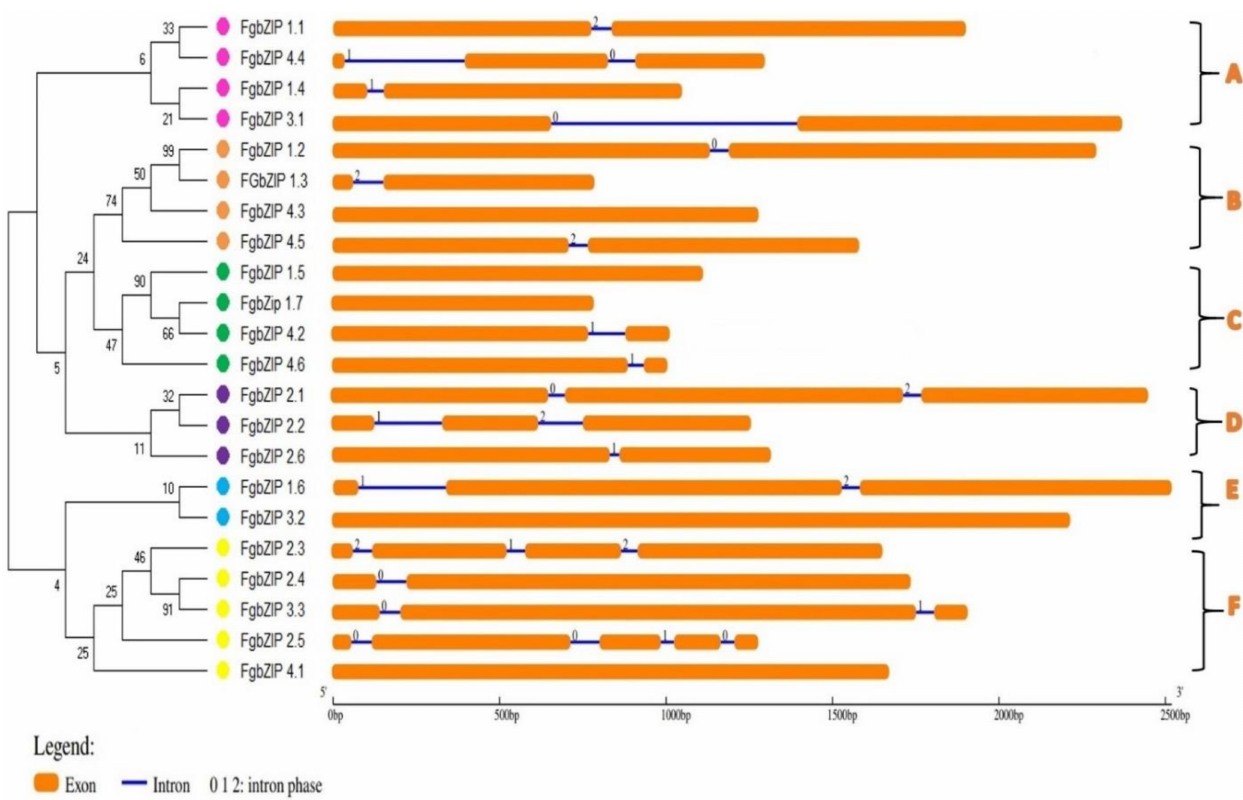
Figure 4. Gene structure of F. graminearum bZIP genes it displays exons, intron and intron phase on a bp scale. The phylogenetic tree on the left was constructed based on the full-length sequences of the FgbZIP proteins. While the alphabets A-F shows